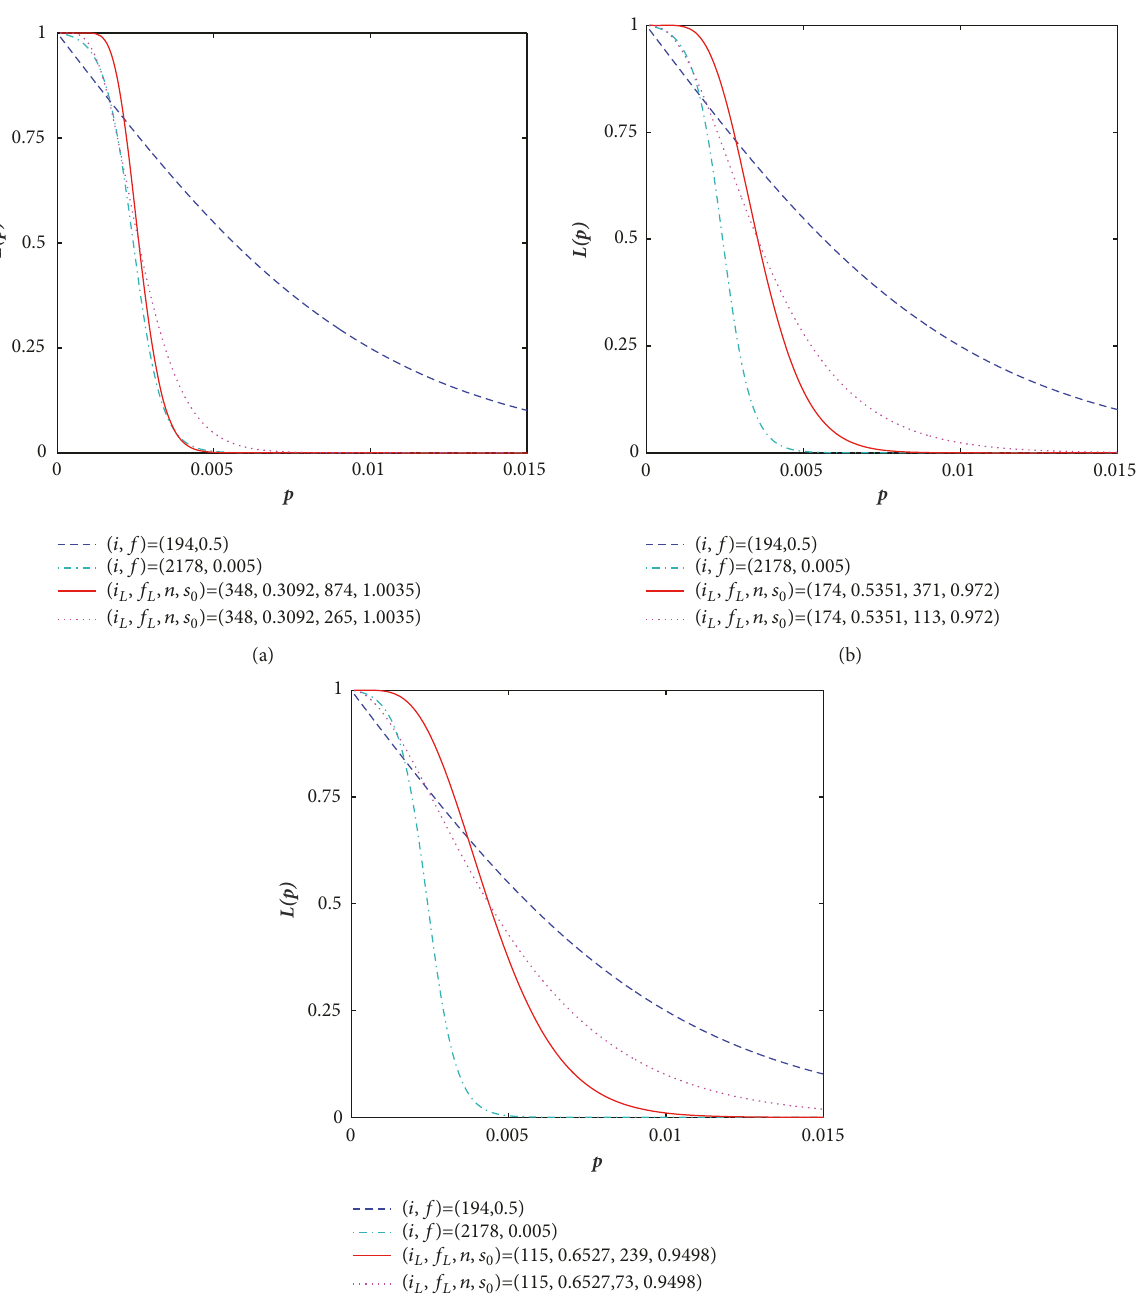
Figure 3: Comparisons of OC curvesfor the optimal schemesand inspection schemesin CSP-1 under AOQL = 0.00143 (a) at 𝐴𝐹𝐼 𝐿 = 0.6667 , (b) at 𝐴𝐹𝐼 𝐿 = 0.8 , and (c) at 𝐴𝐹𝐼 𝐿 = 0.8571